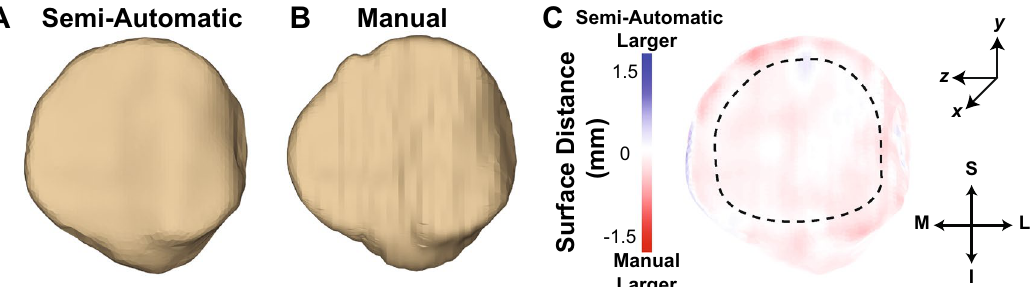
Figure 6. Posterior views of representative 3D bone models of a human patella generated using ( A ) semi- automatic segmentation of sagittal T1 VIBE MR images and ( B ) manual segmentation of sagittal DESS MR images. The same post-processing and smoothing operators were applied to both models. The DESS images had a larger slice thickness as compared to the T1 VIBE images (1 mm vs. 0.7 mm), which may contribute to differences in smoothness between the models. ( C ) The surface distances map shows strong agreement between the 3D models. Blue indicates regions where the semi-automatic segmentation model was larger than the manual segmentation model, whereas red indicates regions where the manual segmentation model was larger than the semi-automatic segmentation model. The black dashed line represents the bone region analyzed after the 25% perimeter reduction of the cartilage boundary, which was implemented to minimize edge effects. Surface distance was defined as the difference between the x-coordinates of the two bone models. T1